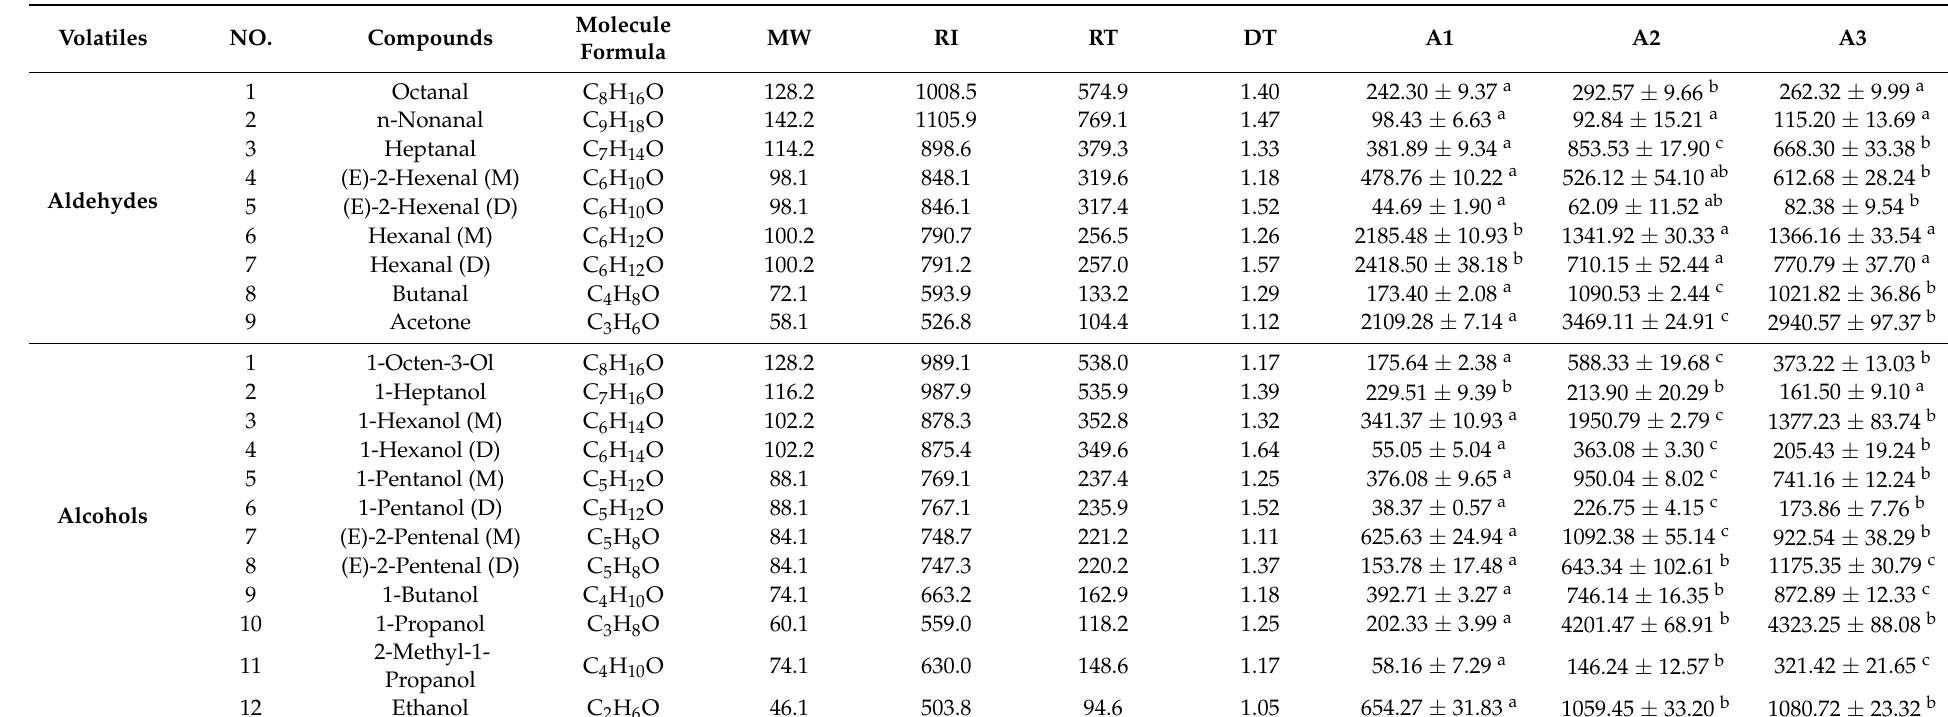
Table 3. Volatile compounds in tuna samples with different treatments by